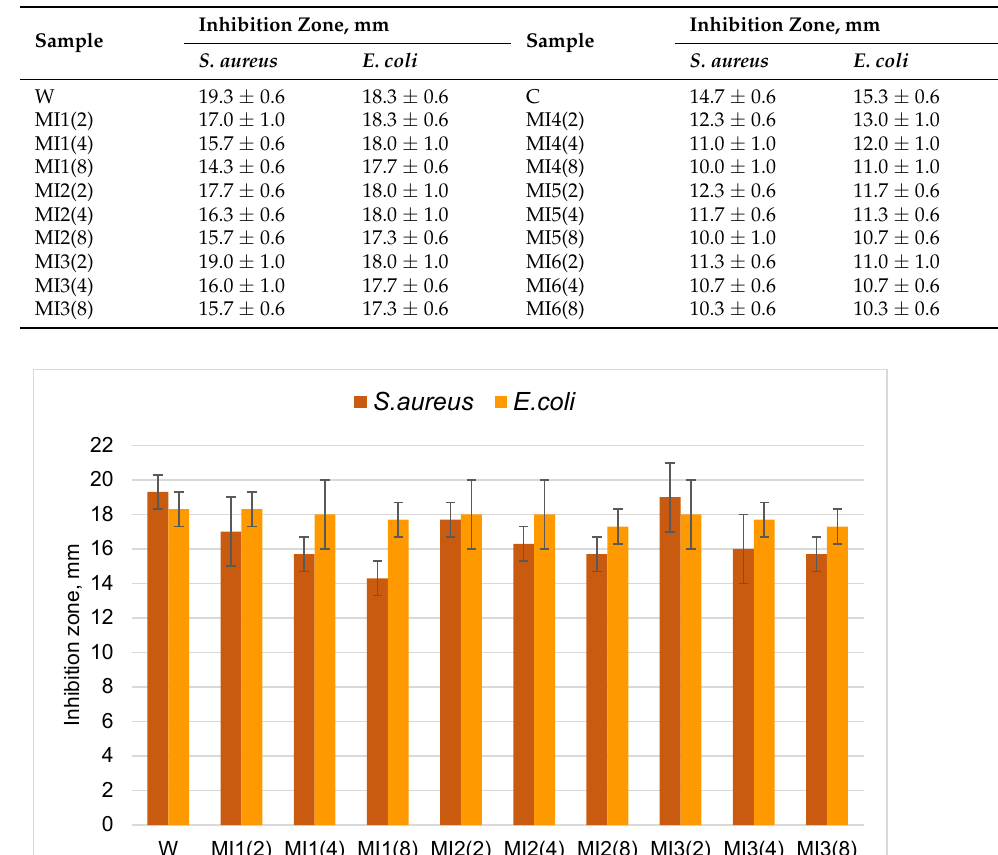
Table 3. Antibacterial results for non-worn samples (W and C) and the mask inserts.